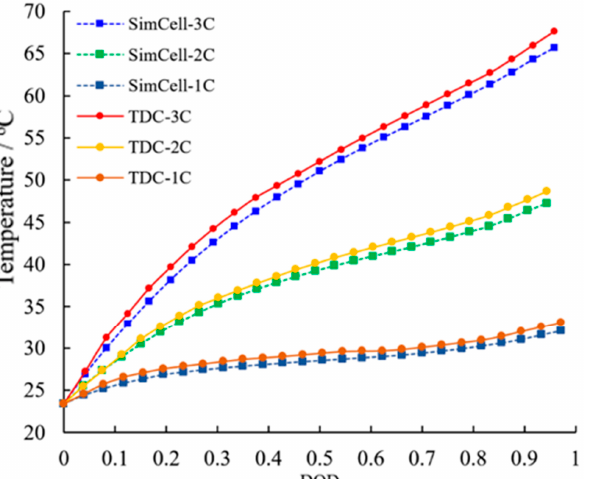
Figure 10. Temperature rising rate at the midpoint on the TDC’s surface compared with a simulation cell at constant discharge current.